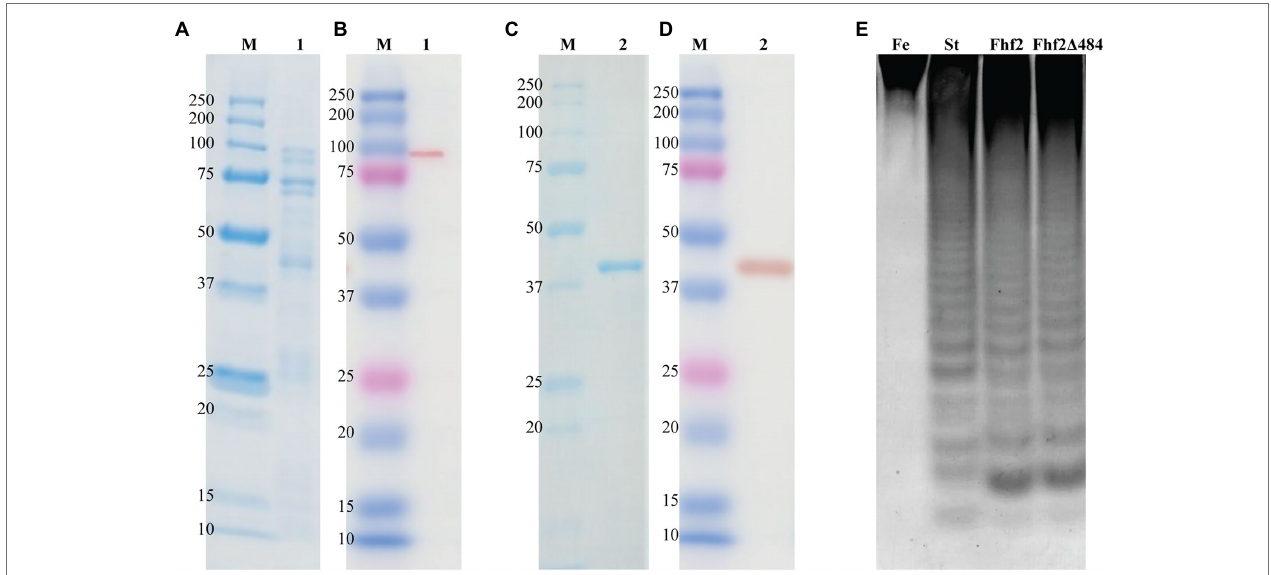
FIGURE 3 | Purification and enzyme activity of Fhf2 and Fhf2 Δ 484. SDS-PAGE and Western blot of Fhf2 ( A,B respectively) and Fhf2 Δ 484 ( C,D respectively). (1) Fhf2 protein with the expected molecular weight of 98 kDa, including other protein bands with lower molecular weight, visible in the SDS-PAGE in (A) , but not in the western blot in (B) . (2) Purified Fhf2 Δ 484 protein with the expected molecular weight of 46 kDa and no other proteins visible. M) Protein marker. (E) Fucoidanase activity by C-PAGE of Fhf2 and Fhf2 Δ 484 on fucoidan fraction 2 extracted from Fucus evanescens (FeF2). (St) oligosaccharide products of the enzymatic reaction of